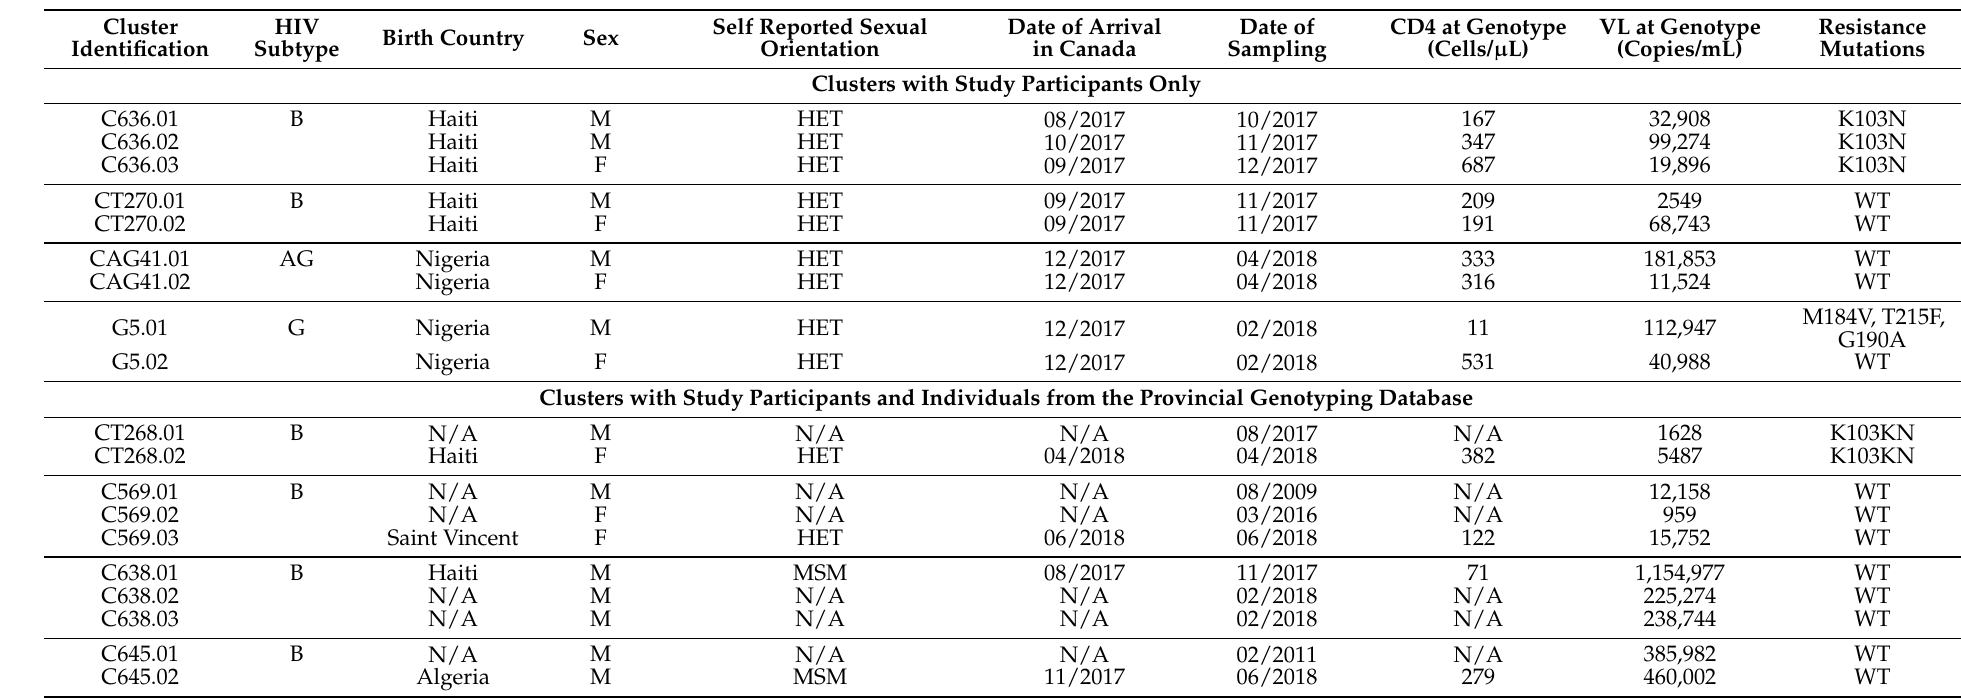
Table 2. Individual cluster characteristics among the study